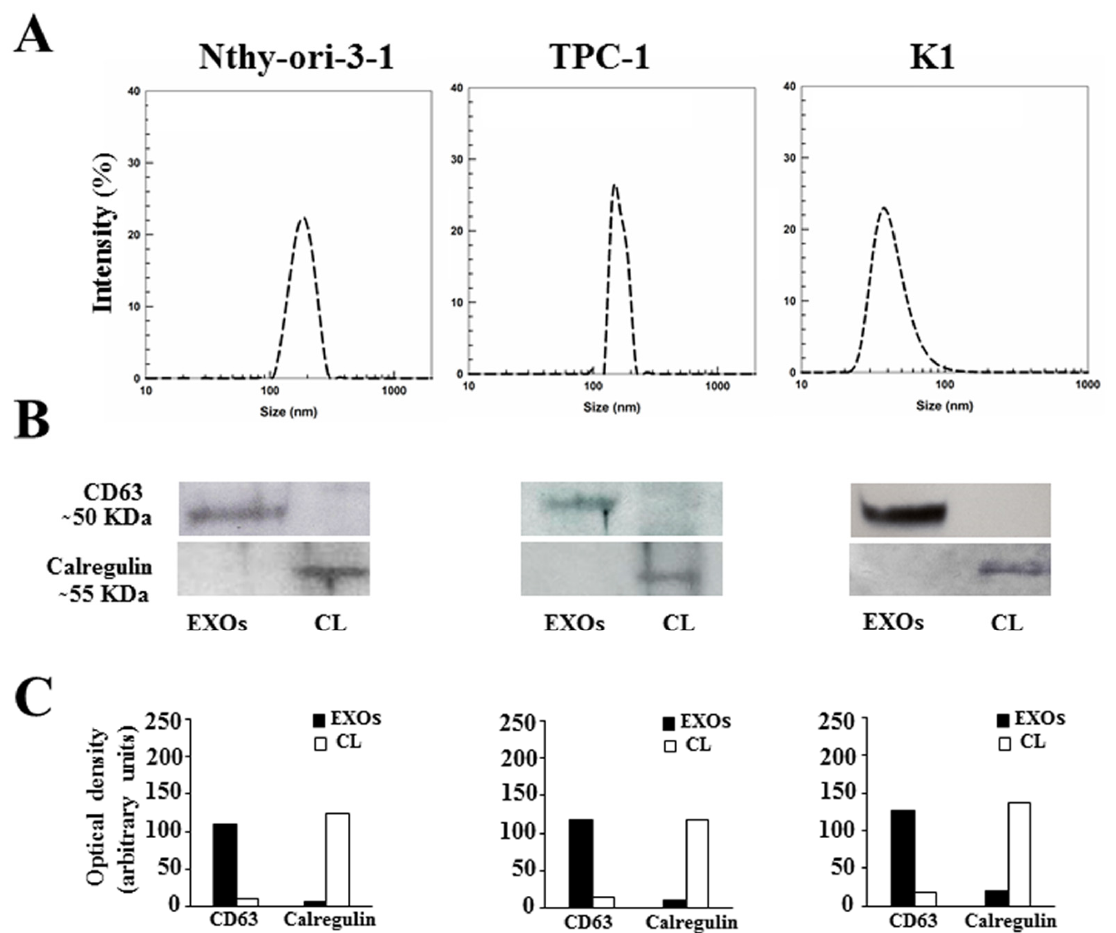
Figure 1. Characterization of Nthy-ori-3-1-, TPC-1-, and K1-cell-derived exosomes: ( A ) Mean sizes of exosomes extracted from conditioned media of Nthy-ori-3-1, TPC-1, and K1 cells. ( B ) Western blotting analysis of CD63 and calregulin in exosomal extracts (EXOs) and whole-cell lysate (CL) of Nthy-ori-3-1, TPC-1, and K1 cells. ( C ) Quantitative results of optical density of CD63 and calregu- lin.